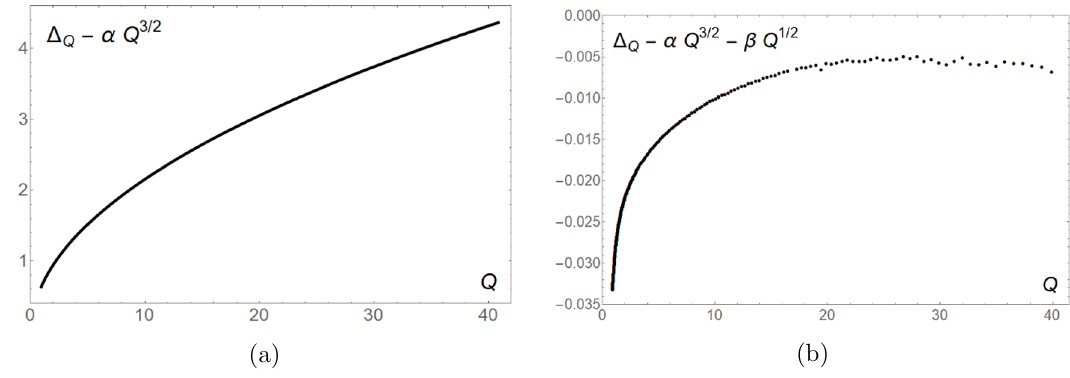
Figure 2. (a) Subtracting the (cid:12)rst term of the (cid:12)t (3.1) from the data reveals a (cid:24) Q 1 = 2 behavior, con(cid:12)rming the subleading term in (1.1). (b) Subtracting also the (cid:12) -term of (3.1) reveals the (cid:24) Q (cid:0) 1 = 2